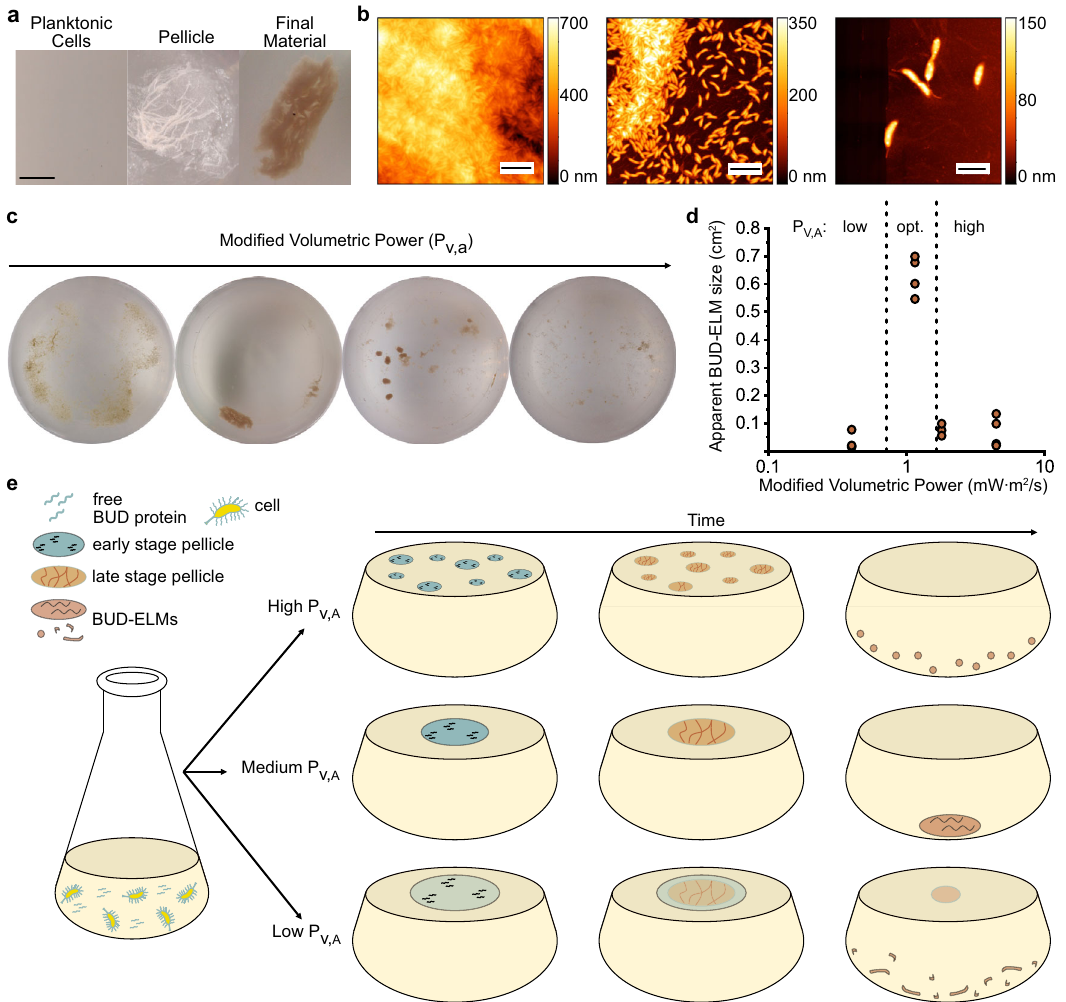
Fig. 3 | BUD-ELMs are formed through a shaking-dependent, multi-step pro- cess. a Optical images of representative BUD-ELM strain culture during material formation, showing BUD-ELMs are formed through a multi-step process. The scale baris1cm. b AFMimagesofpelliclestructure,showingthepelliclecontainsbotha central region containing several layers of densely packed cells (left) and a per- ipheral region containing sparse cells connected by a thin membrane (center and right).Scalebarsare,fromlefttoright,5,5,and2 µ m,respectively. c Representative optical images of BUD-ELMs grown in 250mL fl asks under different modi fi ed volumetric power values. Altering the modi fi ed volumetric power changes the